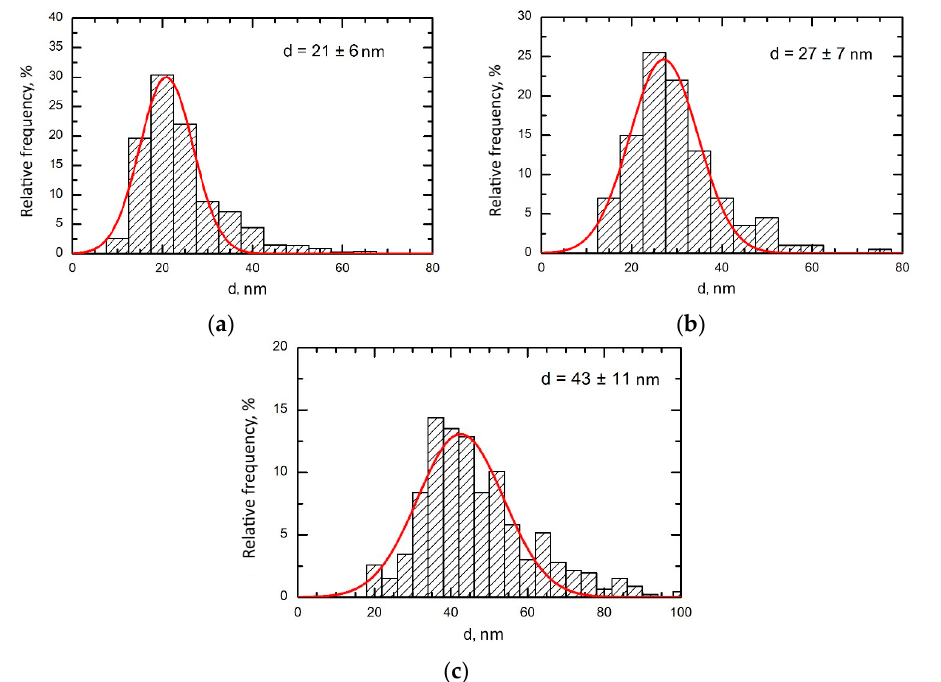
Figure 12. Size distribution functions obtained by statistical processing of SEM images of ( a ) Al 2 O 3 -NP; ( b ) TiO 2 -NP and ( c ) SiO 2 -NP. Arithmetic mean NP diameters (±s.d.) are shown within each panel.